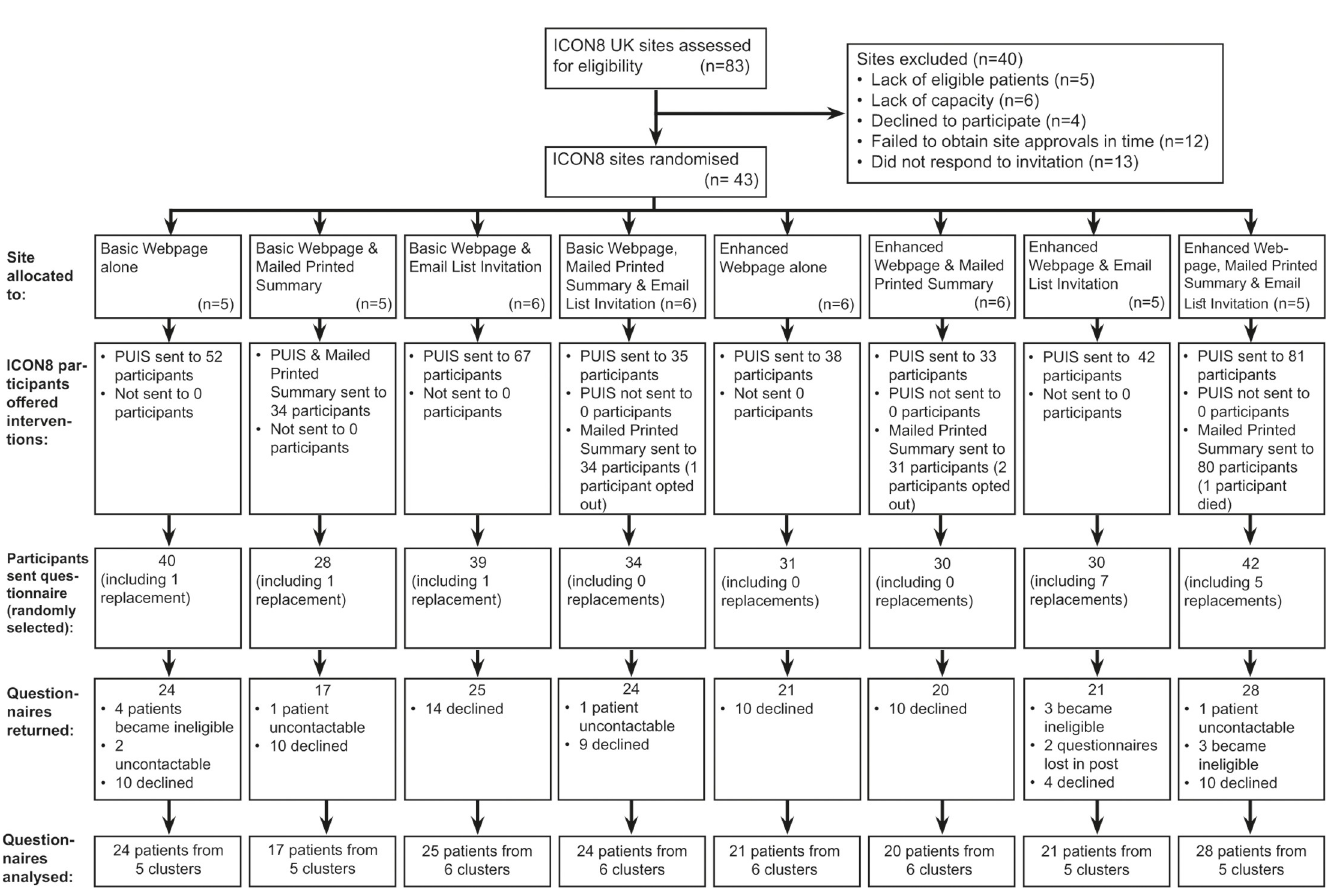
Fig 2. CONSORT diagram for Show RESPECT. CONSORT diagram showing flow of sites and participants through the Show RESPECT